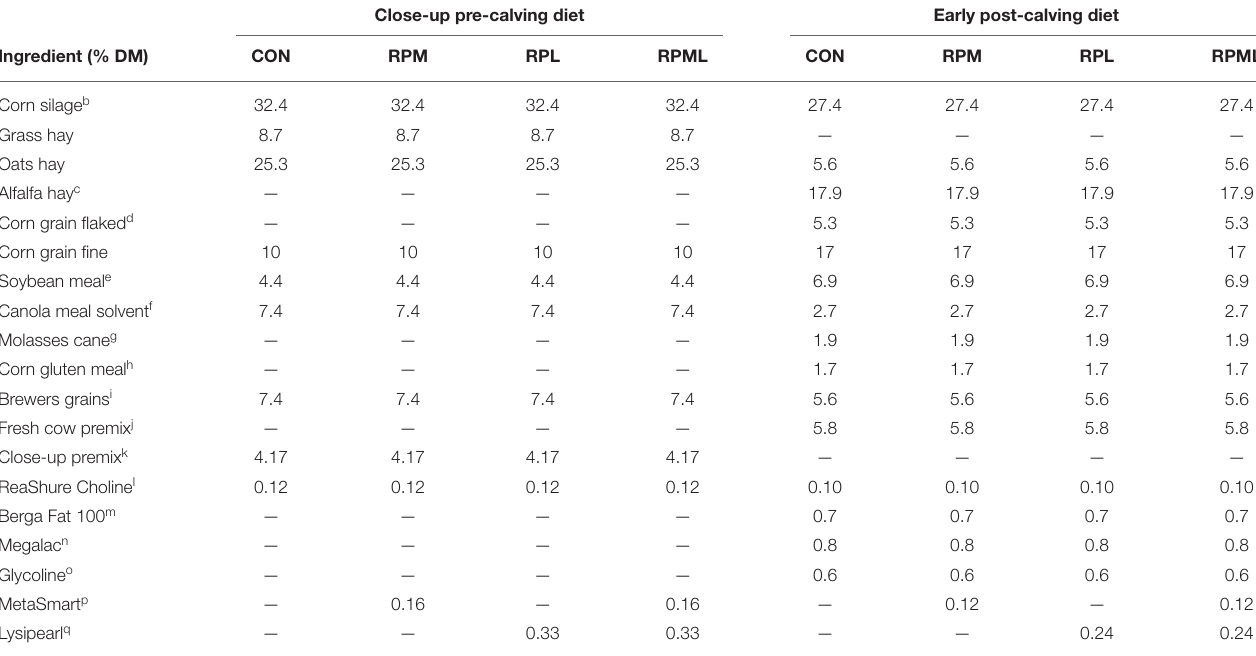
TABLE 1 | Ingredient composition of diets fed to Holstein cows during the transition period [close-up pre-calving diets (the last 3 wk before calving) to the early post-calving (the first 3 wk after calving)] a . Close-up pre-calving diet Early post-calving